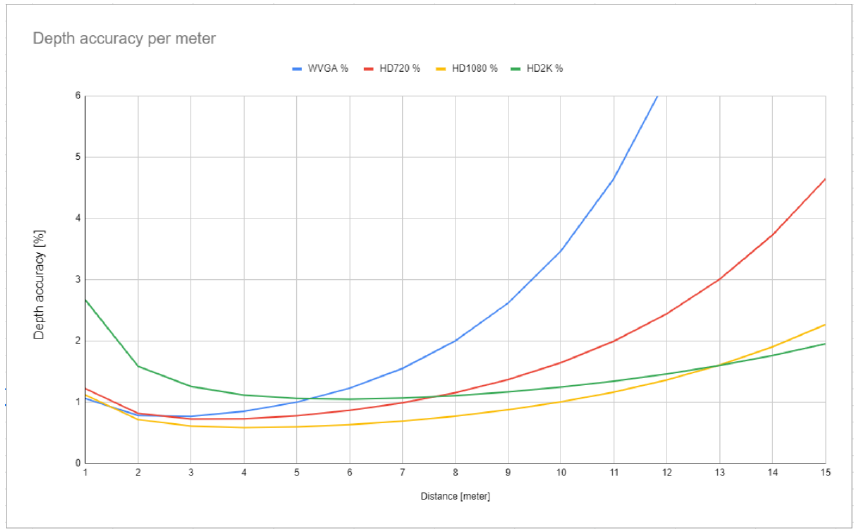
Figure 1. Depth accuracy of the ZED 2 stereo camera in percentages estimated by an exponential model described in [27,28] between 1 and 15